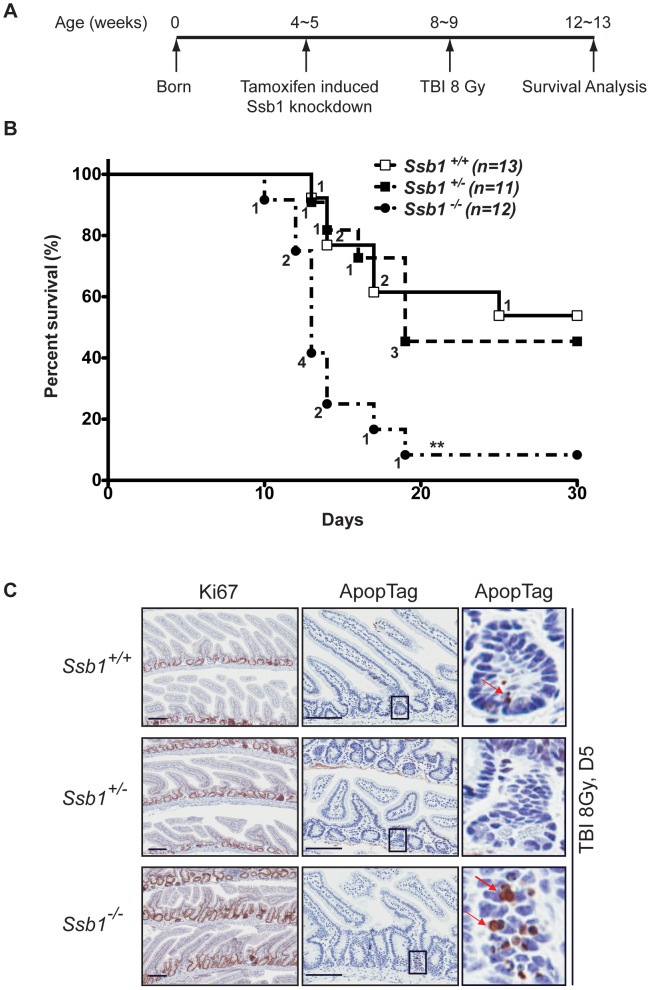
Conditional Ssb1-deleted mice are sensitive to IR.(A) Schematic diagram of the radiation challenge assay in Ssb1 deleted mice. Rosa26-CreERT2: Ssb1
+/+, Rosa26-CreERT2: Ssb1
+/− and Rosa26-CreERT2: Ssb1
−/− mice were challenged with 8 Gy of total body irradiation (TBI). The acute lethal response of mice to TBI was evaluated over a 30-day observation period. (B) Kaplan-Meier survival analysis of irradiated mice. Kaplan-Meier survival curves compared by log-rank (Mantel-Cox) analysis showed significant difference between Rosa26-CreERT2: Ssb1
−/− mice and the other two groups (**P<0.01), while no difference was found between Rosa26-CreERT2: Ssb1+/+ and Rosa26-CreERT2: Ssb1+/− groups. (C) Representative images of Haematoxylin and eosin, Ki67 (cell proliferation) and ApopTag (cell death) staining on small intestine sections from mice at Day 5 post 8 Gy of TBI.